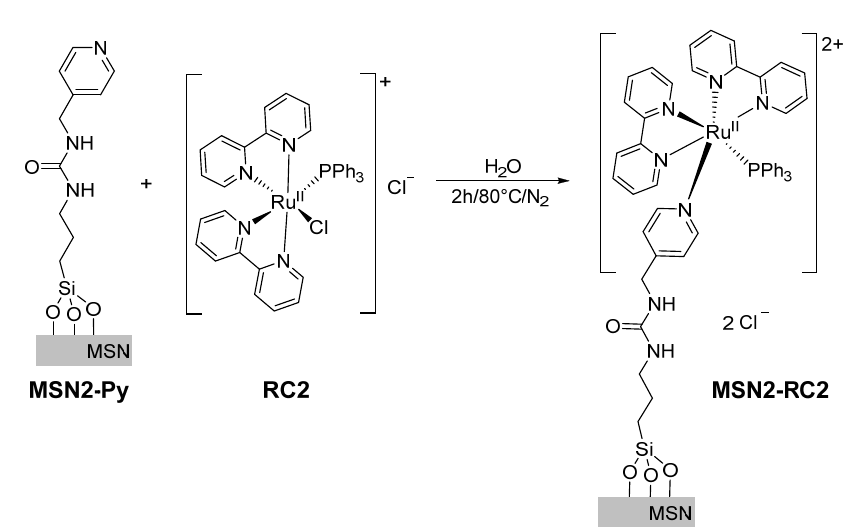
Figure 2. Preparation of MSN2-RC2 by grafting of RC2 onto the mesoporous surface of MSN2-Py.